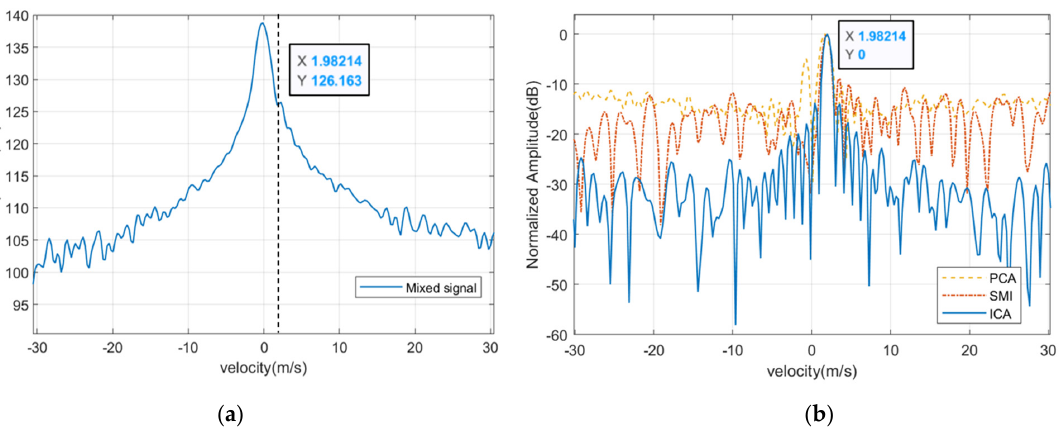
Figure 12. The st − MIMO − ICA result of Target 4: ( a ) velocity spectrum at Target 4 ′ s range bin before st − MIMO − ICA processing, where the target was submerged in strong ground clutter; ( b ) velocity spectrum comparison.